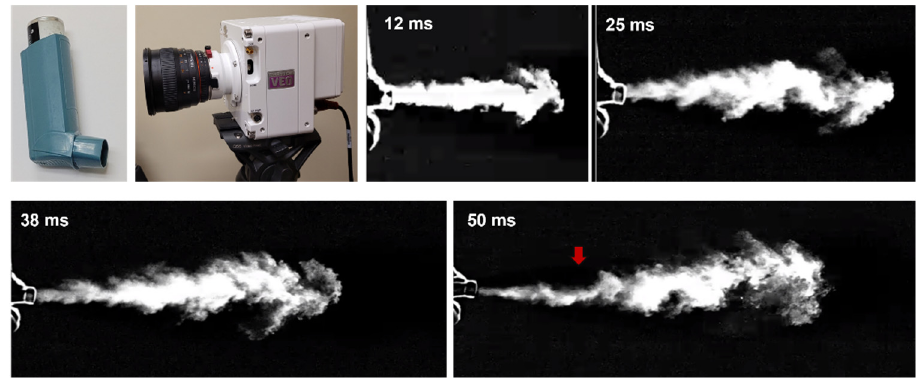
Figure 1. High-speed imaging of MDI